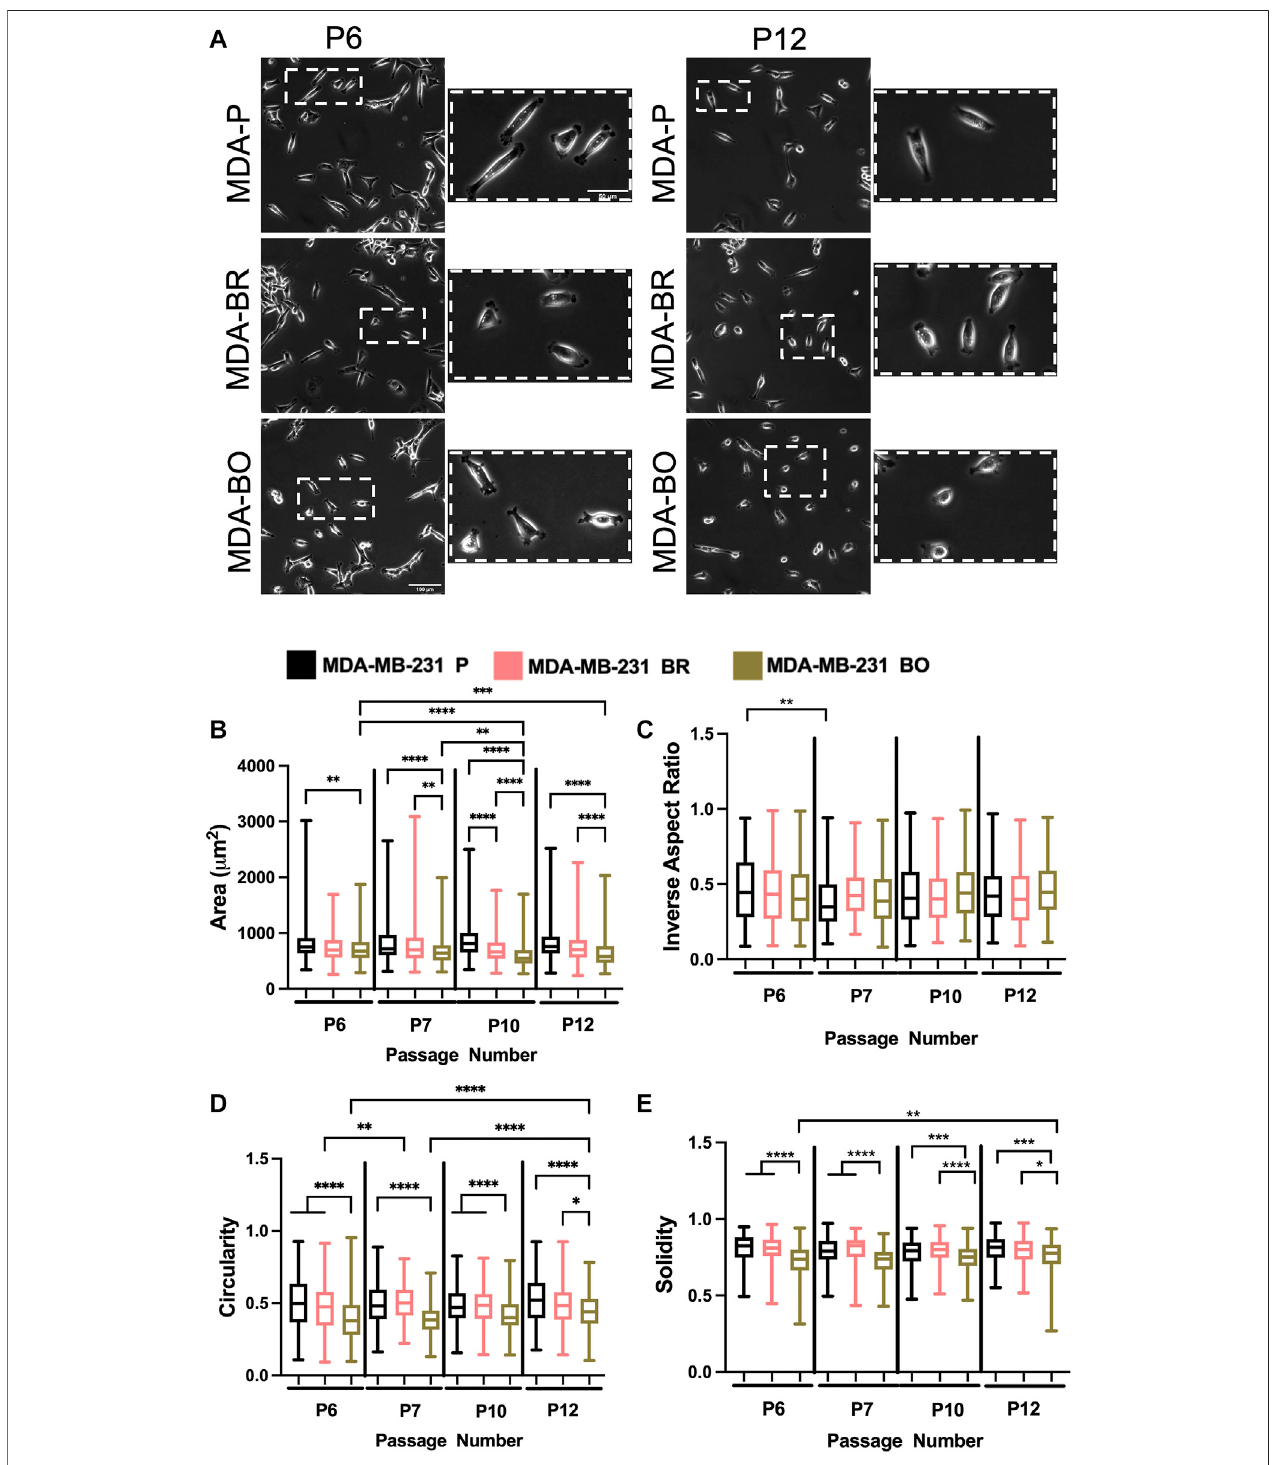
FIGURE2| Effectsofpassagenumberoncellmorphology. (A) PhasecontrastimagesofMDA-P, MDA-BR,and MDA-BOcellsatPassage6(P6)andPassage12 (P12). Scale bars represent 100 μ m (in zoomed out images) or 50 μ m (in zoomed insets). Also shown are quanti fi cation of cell (B) area, (C) inverse aspect ratio, (D) circularity, and (E) solidity as a function of passage number. Box and whisker plots represent the minimum and maximum data points, the median, and the interquartile range. * indicates p < 0.05. ** indicates p < 0.01. *** indicates p < 0.001. **** indicates p < 0.0001. Each column of data is from N > 190 cells pooled from at least 3 independent experiments. The data were tested for normality using the D ’ Agostino and Pearson test. Data for area, inverse aspect ratio, and solidity did not follow a normal distribution, and hence a Kruskal Wallis test and a Dunn ’ s multiple comparison test were performed to determine signi fi cance for those data. Data for circularity partially followed a normal distribution, and hence a two-way ANOVA, and multiple comparison test was performed to determine signi fi cance for that data set.